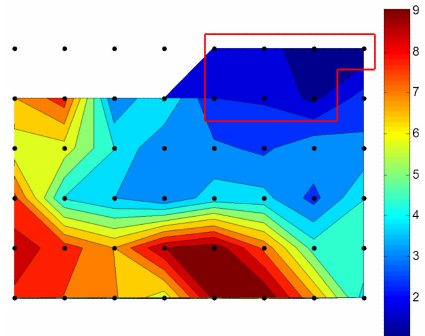
Figure 10. Contour map that displays the profile convergence according to the process conditions. The boundary of the processes having the profile convergence rate less than 2.5% was indicated by red